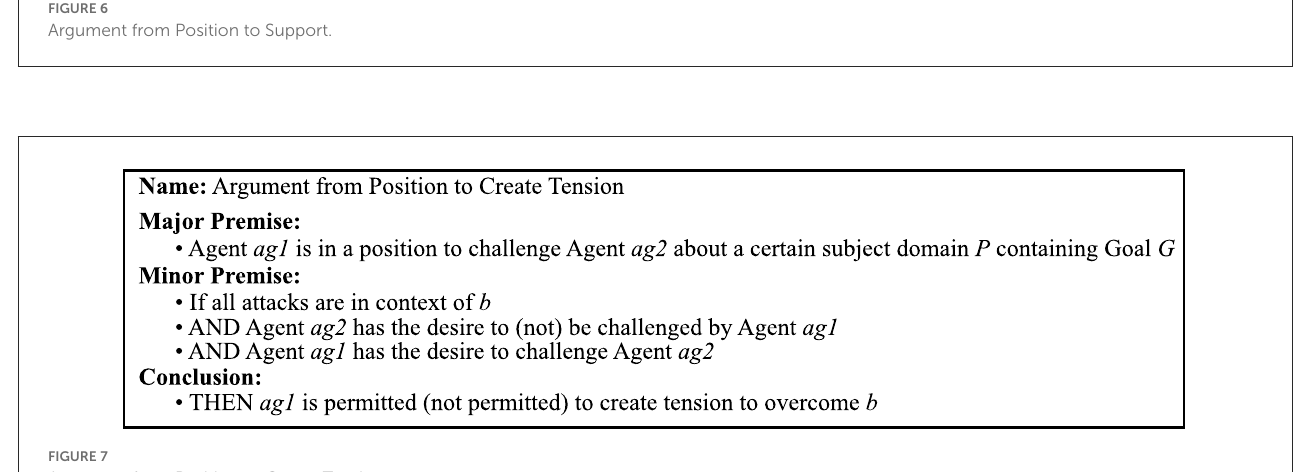
FIGURE6 Argument from Position to Support.